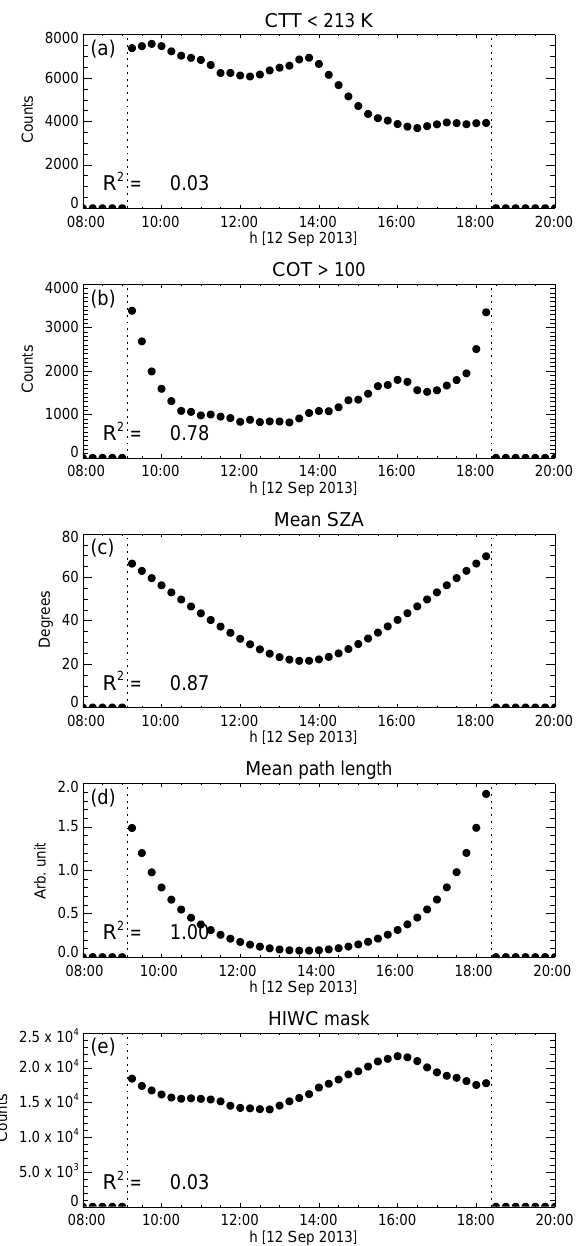
Figure 7. SEVIRI and MSG-CPP statistics of tropical hurricane Humberto on 12 September 2013. Panel (a) shows the number of SEVIRI pixels with cloud top temperatures <213K ( − 60 ◦ C), (b) shows the number of SEVIRI pixels with COT>100, (c) shows the average SZA for the area, (d) shows the mean path length (1/cos(SZA)) of the area, and (e) shows the number of SEVIRI pixels qualifying for the MSG-CPP high IWC mask. Between the dotted lines are the times when data were available for all SEVIRI pixels within the area MSG-CPP. The correlation coefficients de- note the time correlation of the parameter shown within the panel and the mean path length in (d) and only for the period between the dotted